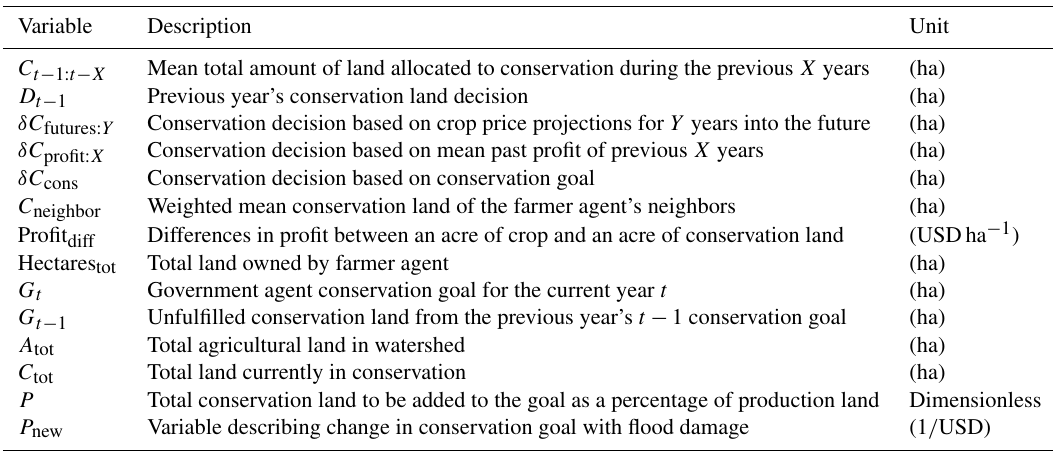
Table 1. Variables in farmer and city agent equations. Variable